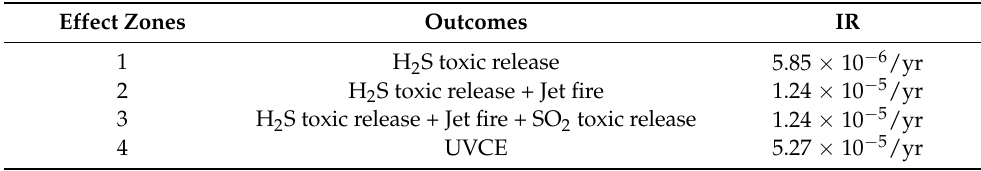
Table 11. Total individual risk (IR) for each effect zone. The outcomes included in each effect zone are listed in the 2nd